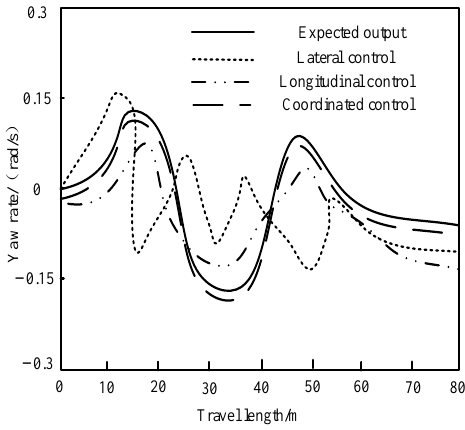
Figure 10. Yaw rate control